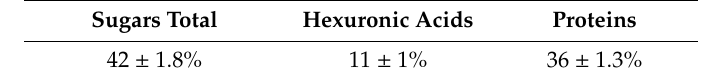
Table 4. Carbohydrate and protein percentage of extracellular polymeric substances (EPS) synthetized by Enterobacter sp. ITCB-09.